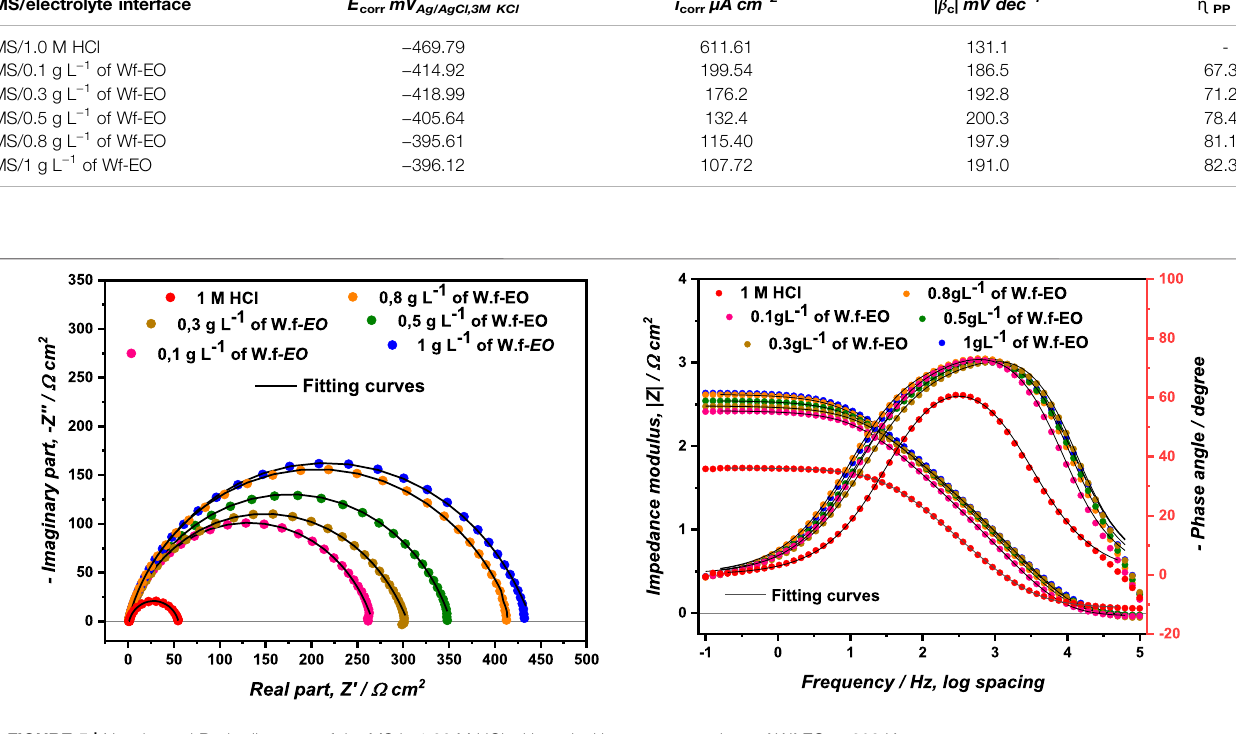
FIGURE 5 | Nyquist and Bode diagrams of the MS in 1.00 M HCl with and without concentrations of Wf-EO at 298 K.